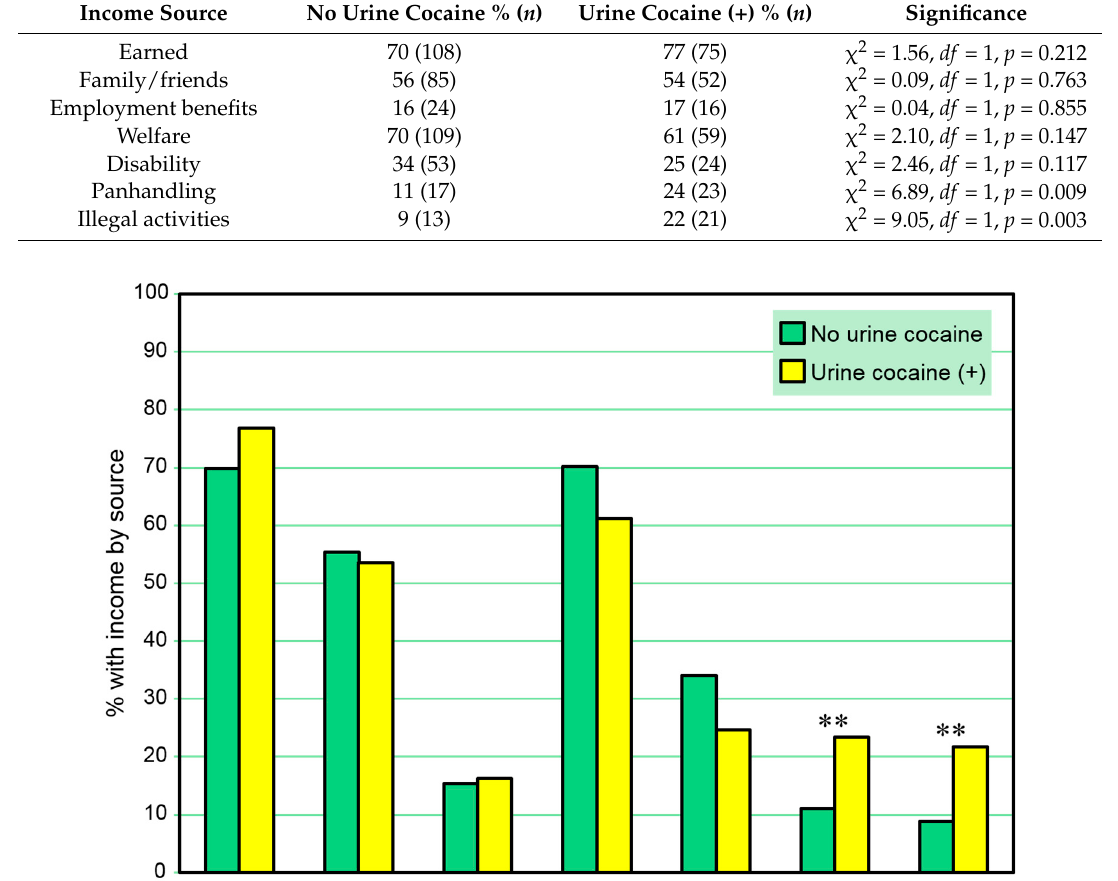
Table 2. Proportions with 30-day income sources among those with and without a positive urine cocaine test in the same month.